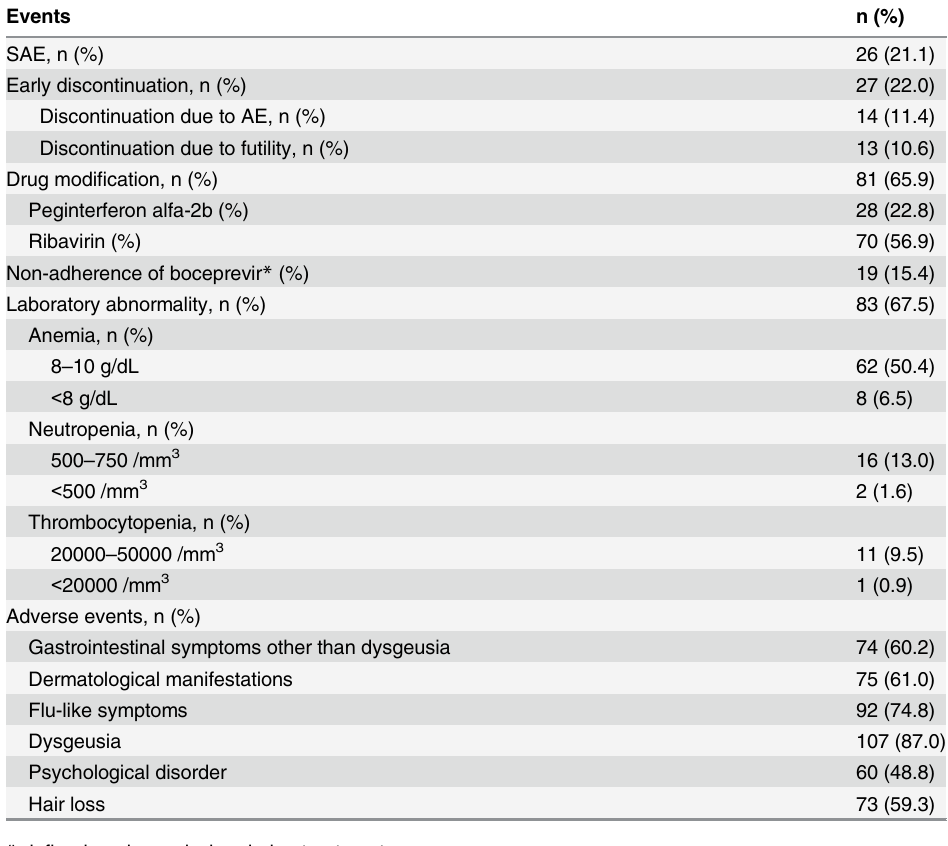
Table 2. Safety profile of boceprevir plus peginterferon/ribavirin triple therapy for HCV genotype 1 treatment experienced patients. Abbreviations: AE, serious adverse event.